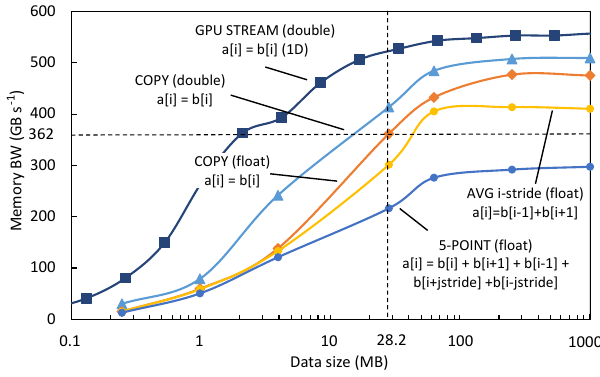
Figure A1. Bandwidth of the representative stencil benchmarks and GPU STREAM on Tesla P100. All kernels (except for GPU STREAM) operate on a 3-D